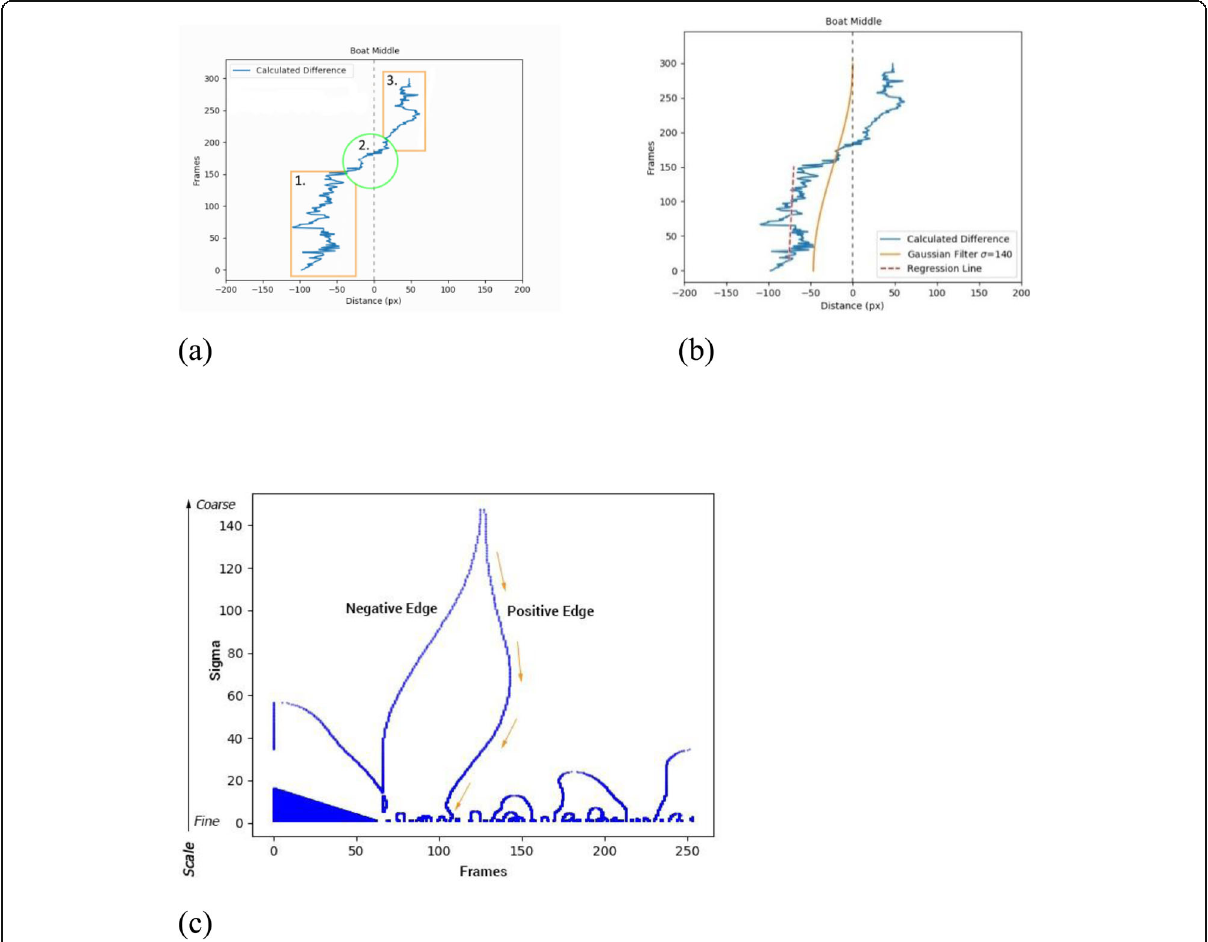
Fig. 5 Tracking plots involved in maneuver detection. a : Segments of a sailing maneuver. (1) Sailors stable on left side, (2) crossing the middle of the boat, and (3) stable on the right side; b : Regression line before zero crossing. Orange line is the output of the (too) coarsely filtered calculated difference; c : Adaptation to frames using edge focusing signature graph at different values of σ , allowing tracking from coarse to